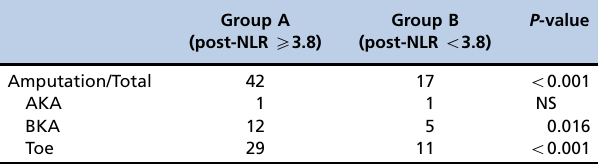
Table 2 - Amputation comparison between Groups A and